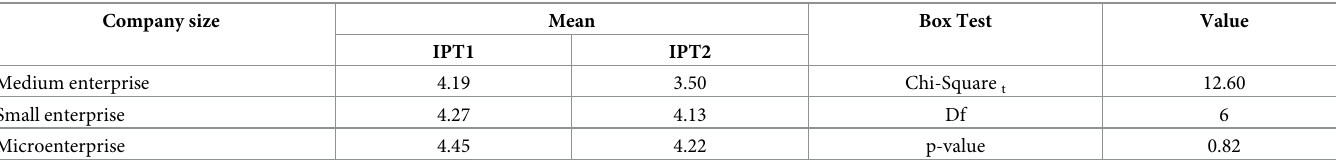
Table 8. Interpersonal trust level and the Box